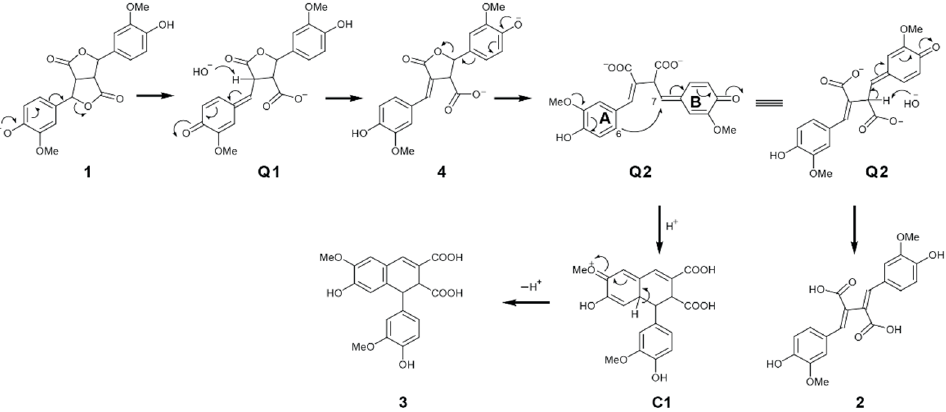
Figure 4. The proposed mechanisms leading to the formation of compounds 2 and 3 .